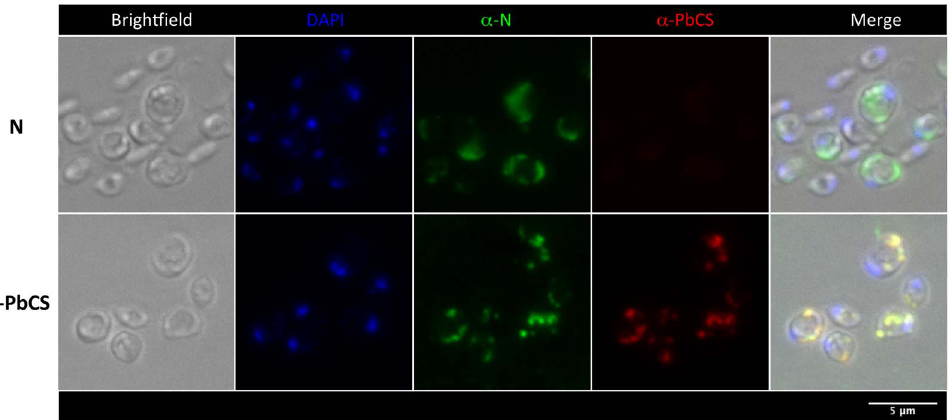
Figure 5. Immunofluorescence analysis of N or N-PbCS expression in yeasts (N staining in green, PbCS staining in red and nuclei in blue). Each image is the maximal intensity projection of three consecutive focal planes spaced 0.5 m m apart.